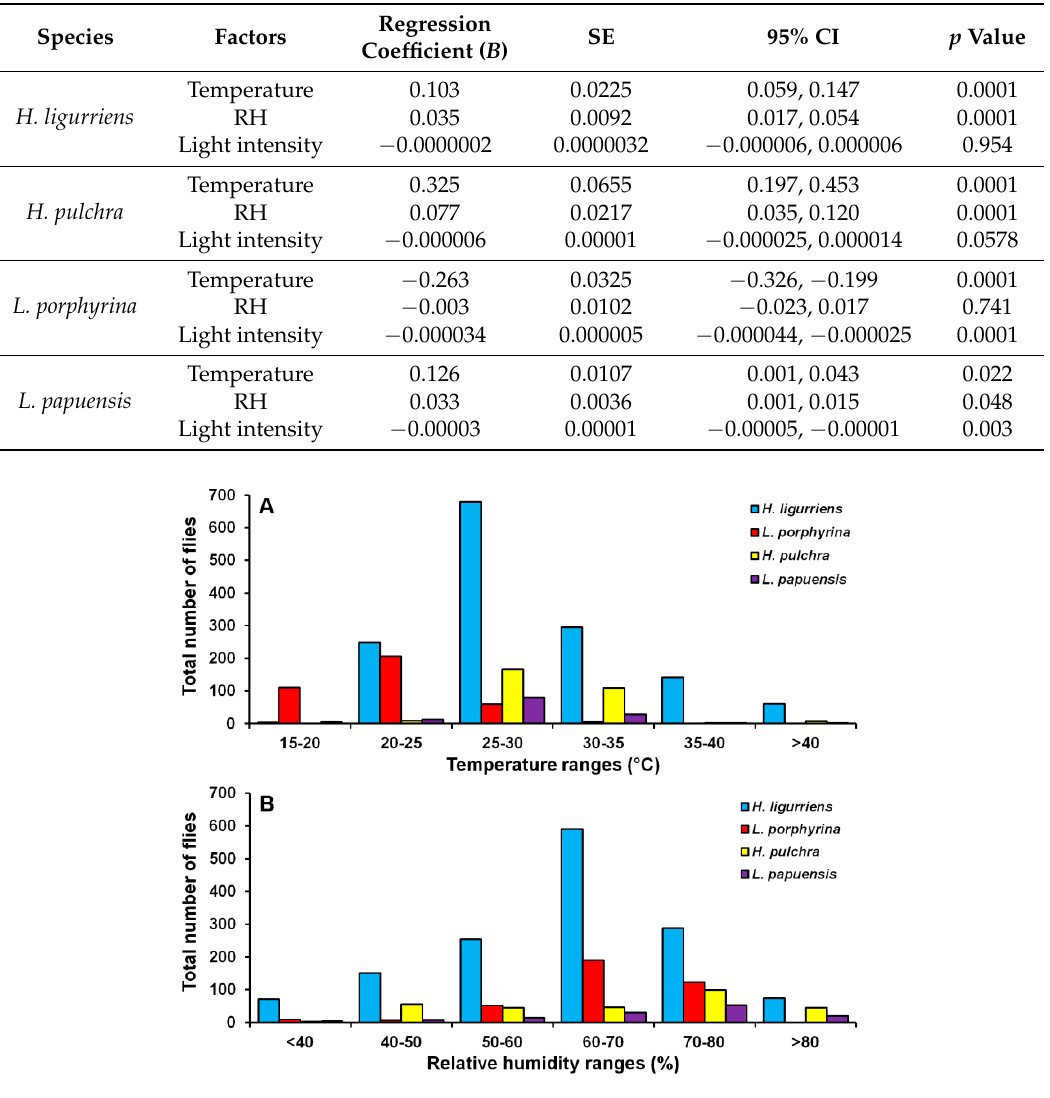
Figure 3. Total number of flies captured at different temperature ( A ) and relative humidity ranges ( B ).